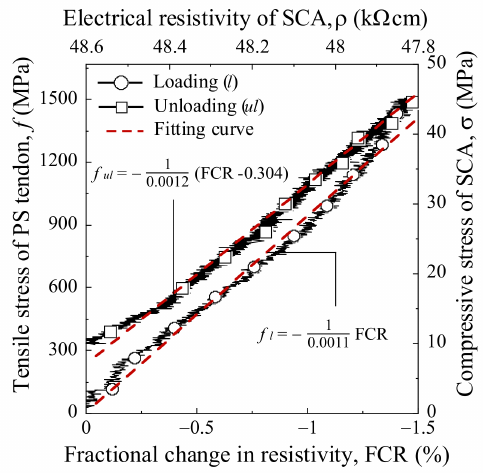
Figure 16. The tensile stress of PS tendon versus FCR curves of the prototype of